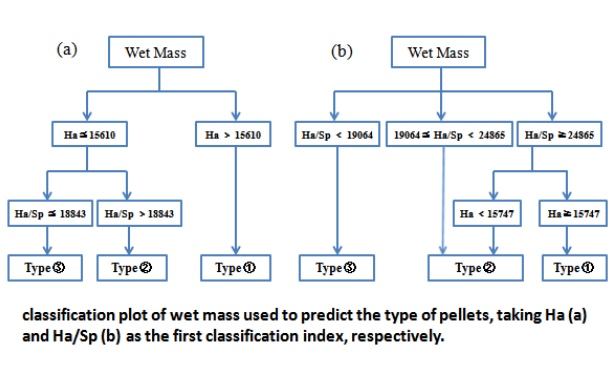
FIGURE 6 - classification plot of wet mass used to predict the type of pellets, taking Ha (a) and Ha/Sp (b) as the first classification index, respectively.